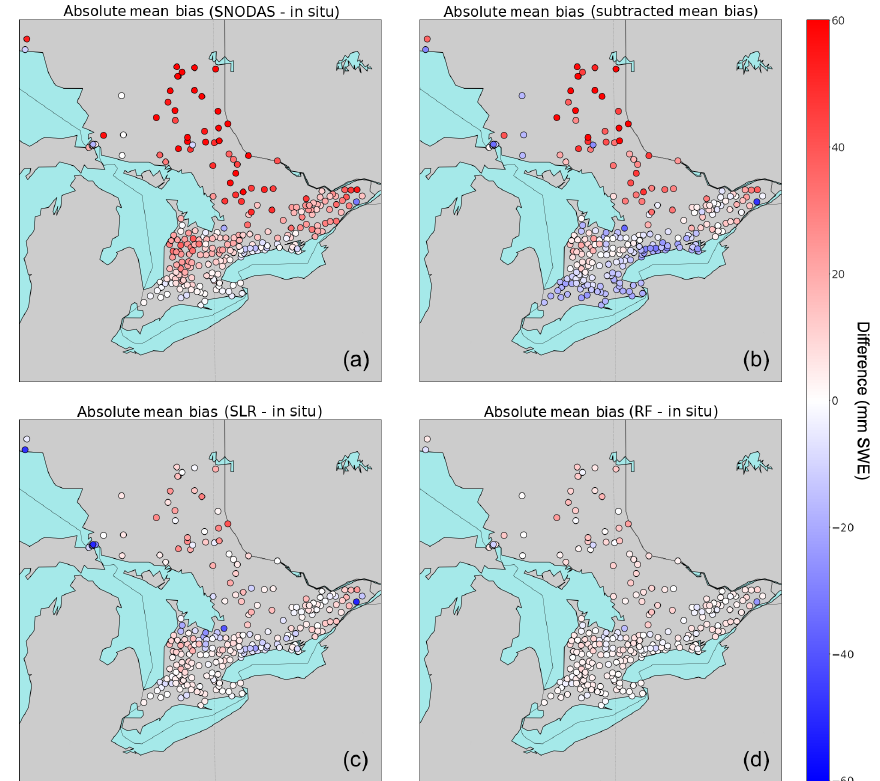
Figure 4. Absolute mean bias comparisons between in situ SWE and (a) SNODAS, (b) MBS, (c) SLR, and (d) RF, averaged at each snow survey site over the full study period.